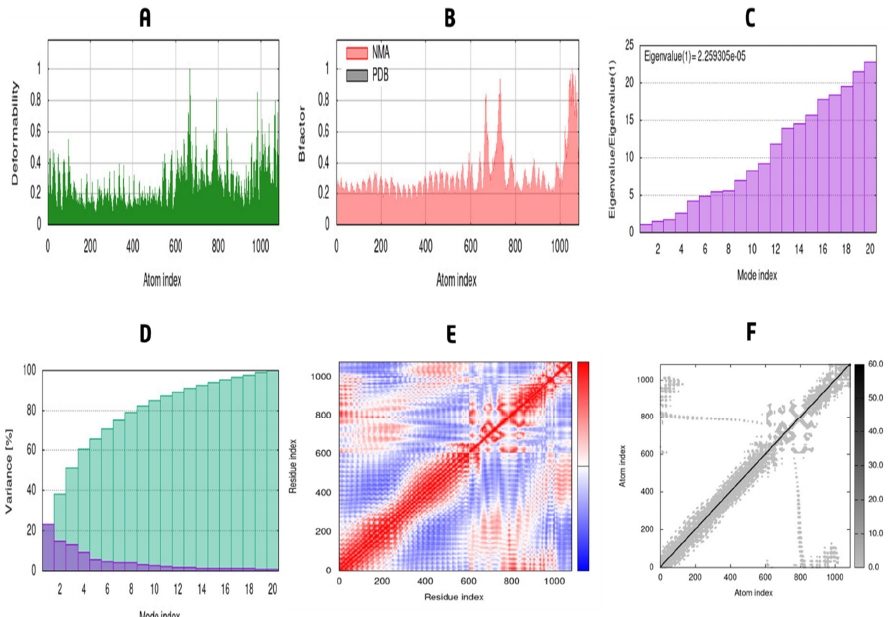
Figure 10. The multi-epitope vaccine complex is simulated. A multi-epitope docked vaccine candidate is shown in the RMSF figure. Red and blue backgrounds, respectively, emphasize the alpha-helical and beta-strand portions. These places are identified by helixes or strands that last for 70% of the simulation time.